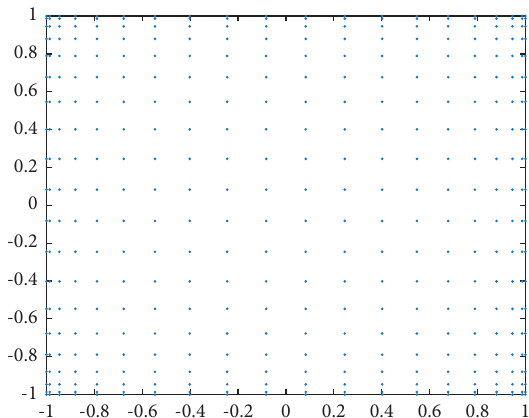
Figure 1: Configuration of the points in the Chebyshev-type